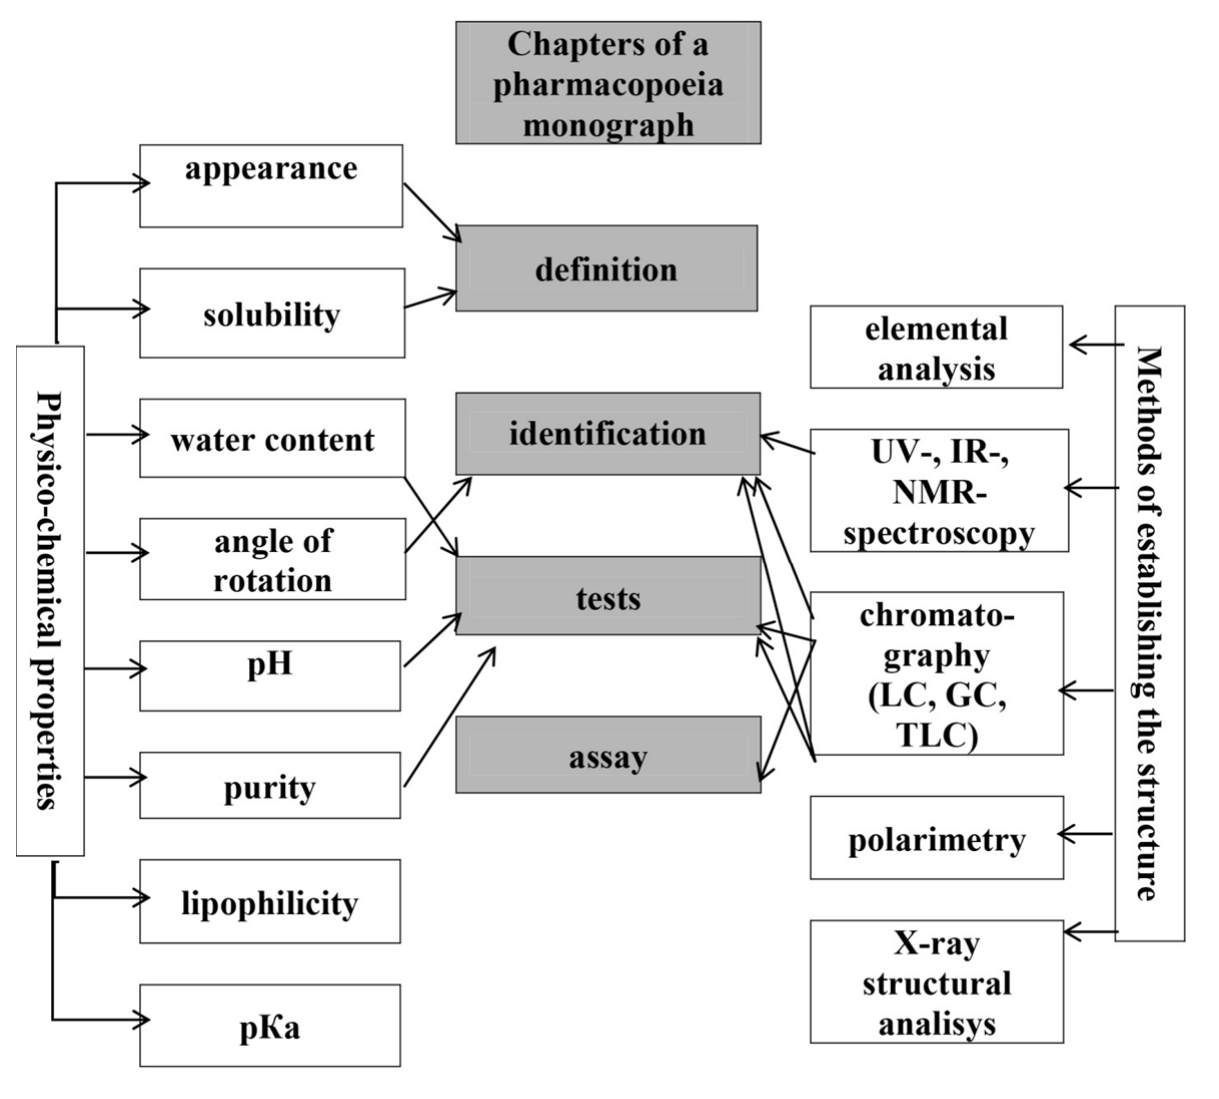
Fig. 1. Correlation of methods of structure proving and study of physico-chemical properties of BAS with pharmacopoeial quality